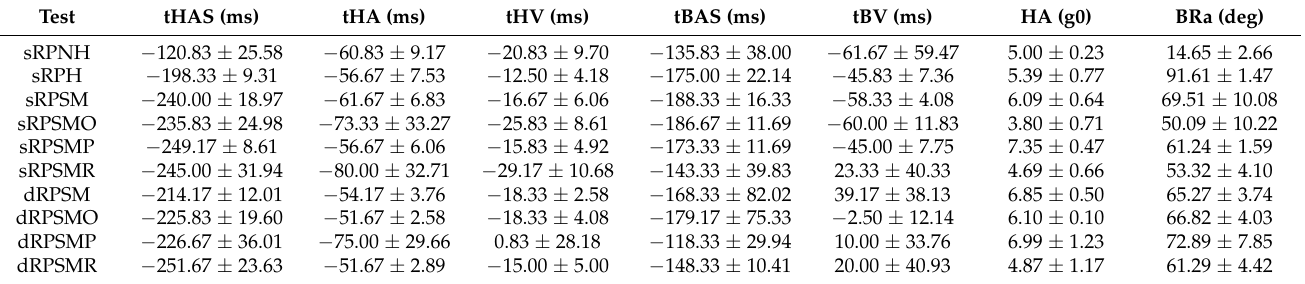
Table 1. Hand and body temporal and kinematic parameters (MEAN ± SD) in the ten test modalities.